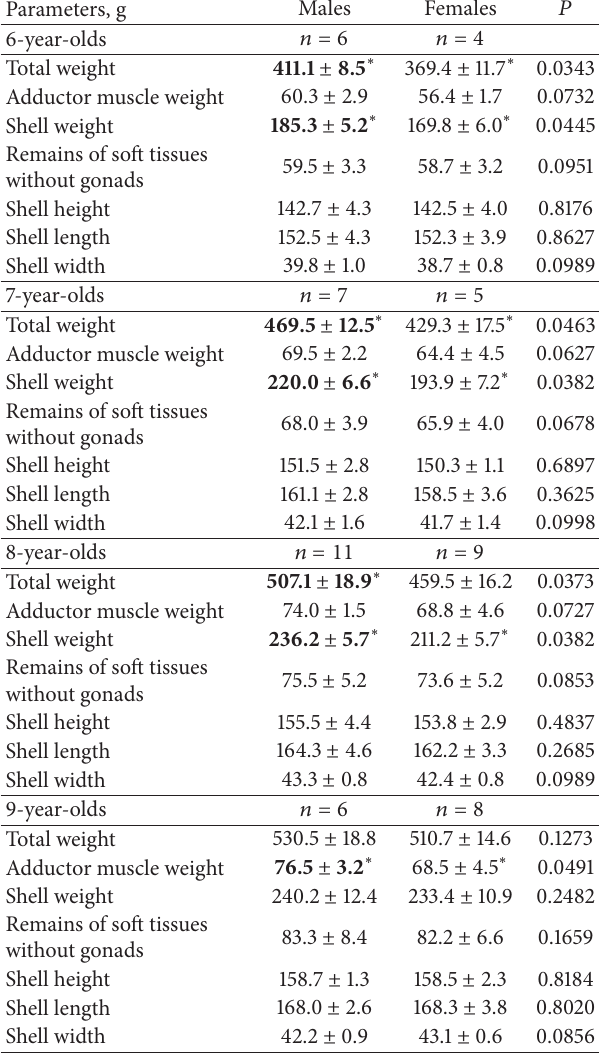
Table 3: Patinopecten yessoensis . Wet weight and size parameters of the same aged males and females from the population inhabiting Vityaz Bay. ∗ indicates significant differences between parameters at a level 𝑃 < 0.05 ( 𝑡 -test). Bold marks higher values. 𝑛 is sample